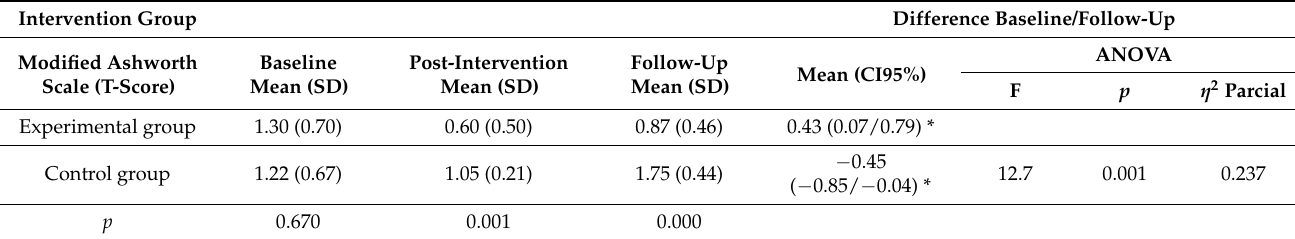
Table 2. Linear model. Effect of the intervention on Modified Ashworth Scale results.